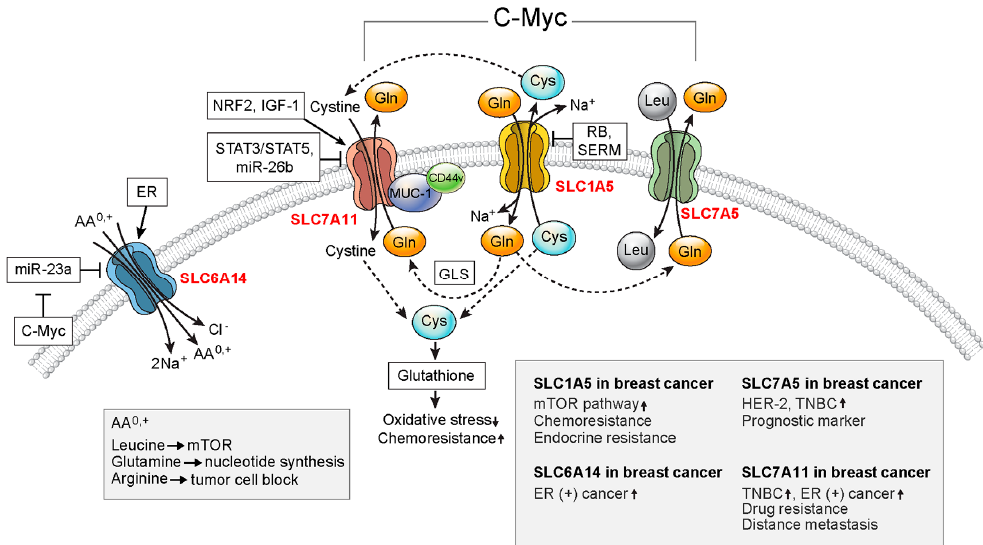
Figure 1. Important amino acid transporters in breast cancer. SLC1A5, SLC6A14, SLC7A5, and SLC7A11 are upregulated in breast cancer. SLC1A5, SLC7A5, and SLC7A11 exhibit functional coupling and enhance the proliferation of cancer cells. SLC7A11-mediated intracellular cysteine is used for glutathione synthesis, which results in reduced oxidative stress. c-Myc acts as a positive regulator for SLC1A5, SLC6A14, SLC7A5, and SLC7A11. STAT5: signal transducer and activator of transcription 5; ER: estrogen receptor; GLS: glutaminase; SERM: selective estrogen receptor modulator; mTOR: mammalian target of rapamycin; HER-2: human epidermal growth factor receptor 2; TNBC: triple- negative breast